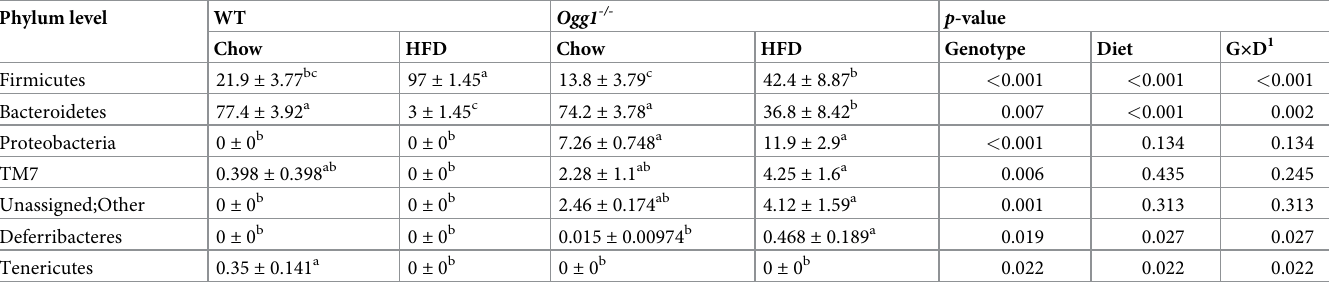
Table 1. Composition of gut microbiota at the phylum